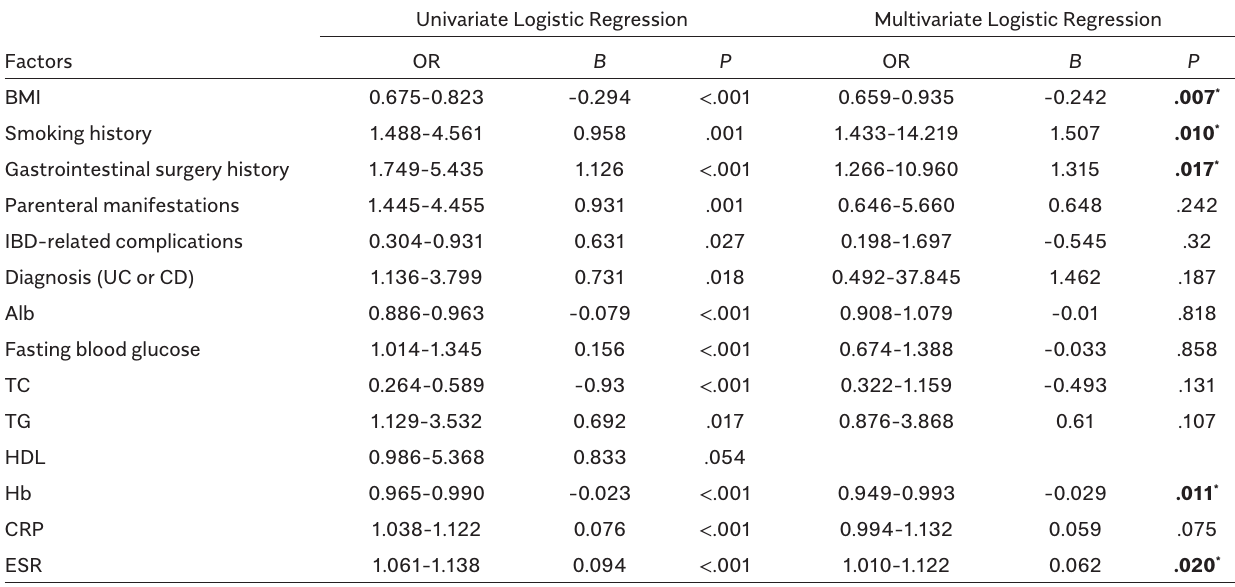
Table 2. Risk Factors of IBD Patients with Low Muscle Mass